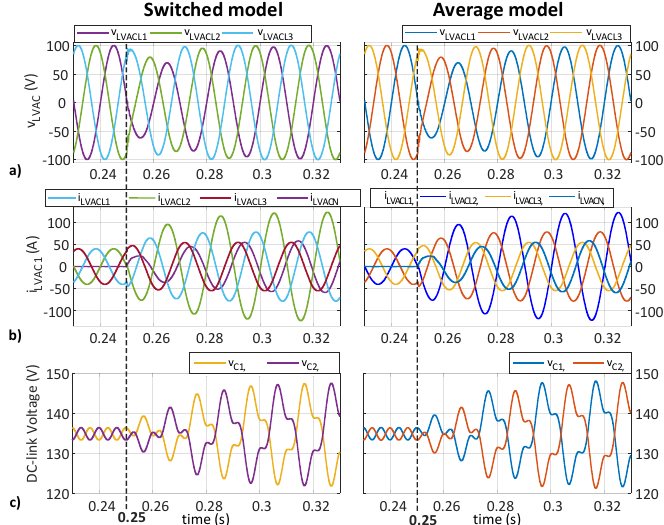
Figure 12. The voltages and currents of the T-type converter, ( a ) LV grid (load) voltages, ( b ) load currents, ( c ) DC-link voltages—across upper and lower capacitors.